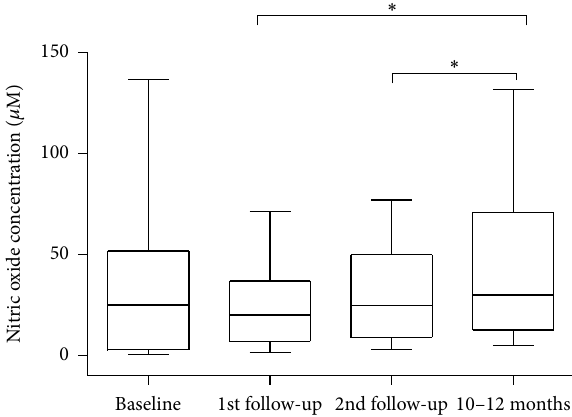
Figure 3: Box-whisker plot of changes in nitric oxide levels ( 𝜇 M) in unstimulated whole saliva during follow-up sessions after insertion of new complete dentures ( 𝑛 = 19). Box limits represent 25 and 75 percentiles, the line within the box represents median, and the whiskers represent minimum and maximum values ( ∗ 𝑝 < 0.05; Wilcoxon matched-pairs signed rank